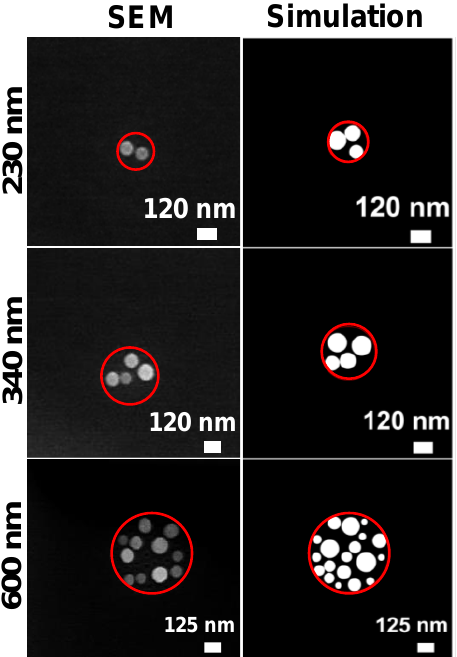
Figure 5. SEM images ( left ) of Ga droplets after area-selective deposition and thermal annealing for varied diameters d of the mask aperture, together with corresponding simulated surface morphologies ( right ). The red circles indicate the size of the aperture. The experimental and simulation parameters for the area-selective deposition step are as in Figure 2. Thermal annealing is performed for 5 min at T = 400 °C. The simulations of the annealing step use a T -dependent E E , as is described in the